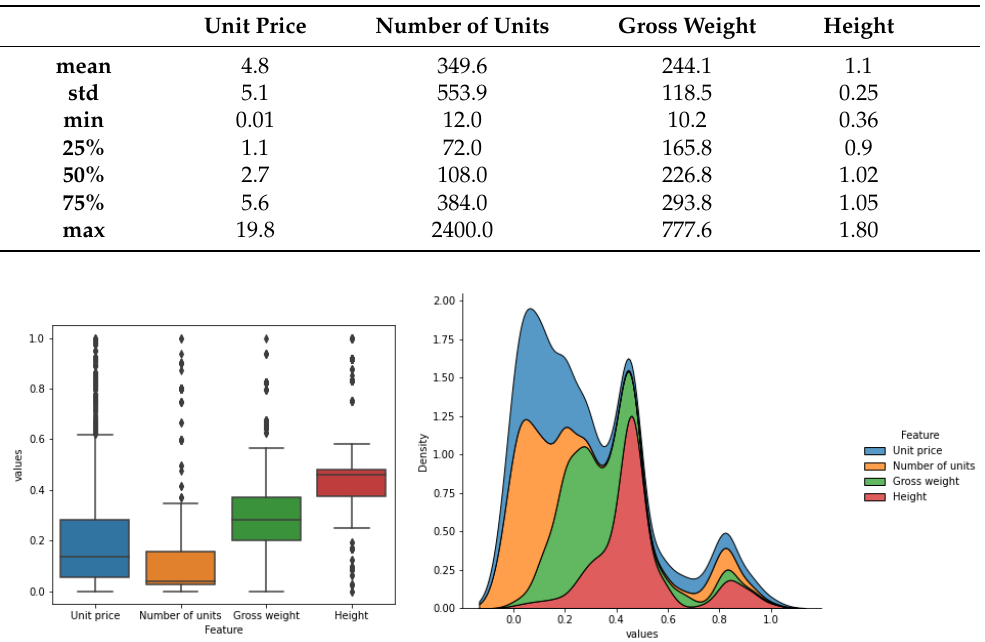
Table 2. Measures of central tendency, dispersion, and quartiles.